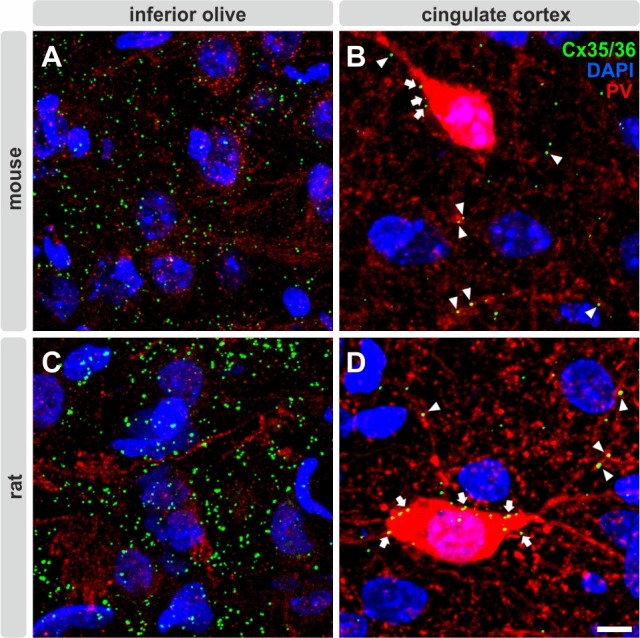
Cx35/36 immunostaining in the inferior olive and cingulate cortex in rat and mouse.Coronal maximum intensity projections of high power confocal micrographs from C57BL/6 mice (A B) and SD rats (C D) stained for parvalbumin (PV; red), connexin-36 (Cx36; green) and DAPI (blue). Note high density of Cx36- immunoreactive (-ir) puncta in the inferior olive (A C) as well as Cx36-ir puncta in close proximity to PV-ir cell somata and dendrites in the cingulate cortex in both mice (B) and rats (D). Scale bar in (D) = 5 µm for (A–D).